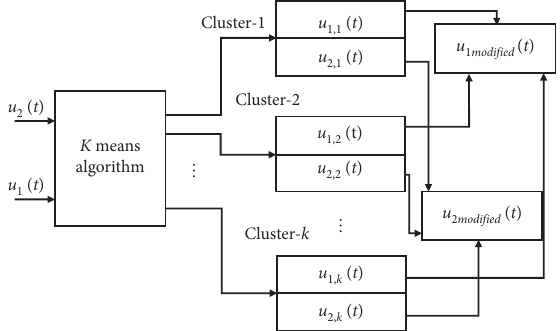
Figure 3: K -means clustering for inputs u